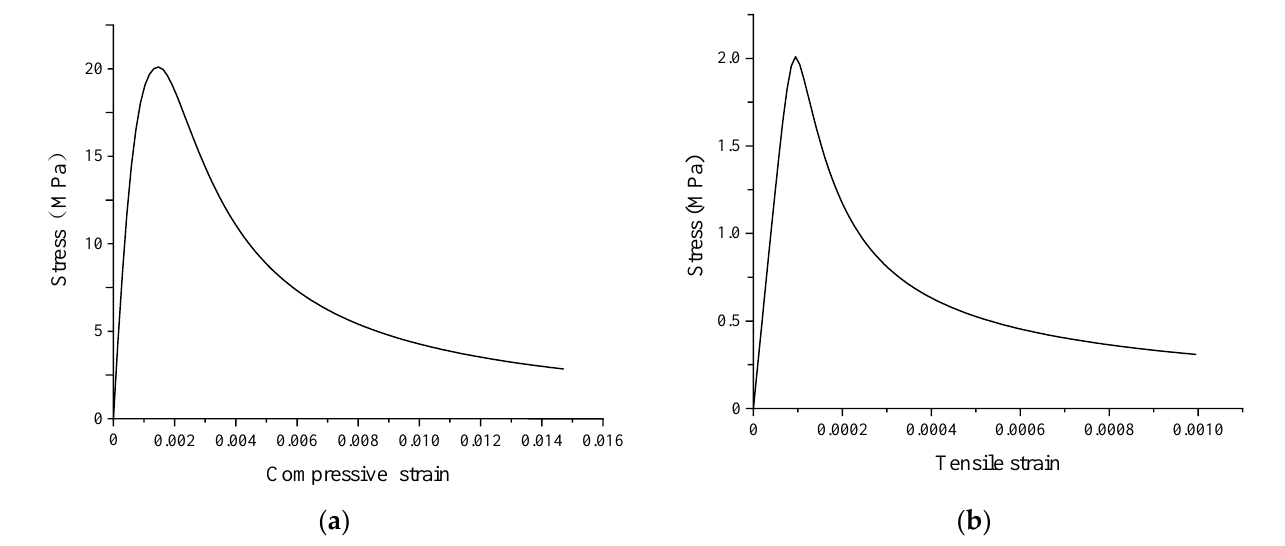
Figure 6. Stress – strain relationship of the concrete-damaged plastic model: ( a ) compressive stress – strain curve; and ( b ) tensile stress – strain curve.